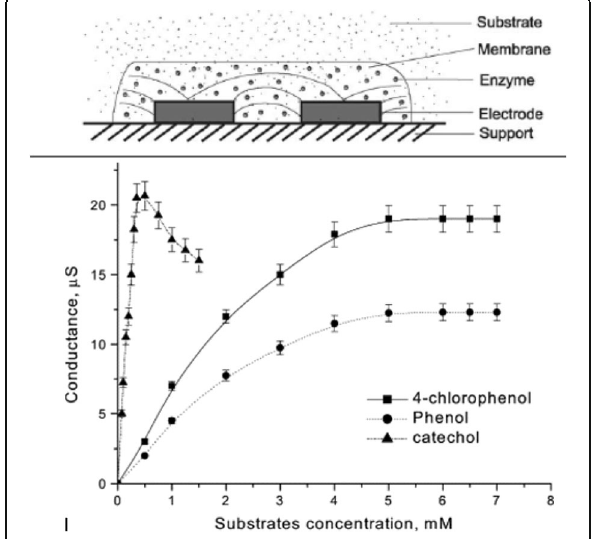
Fig. 14 a Nyquist plots of the MCH/aptamer/AuNPs/gold electrode correspond to different concentrations of acetamiprid. b The dependence of R et of on the concentration of acetamiprid; inset is the linear calibration curve of with permission from Reference Fan et al. 2013). © 2013 Elsevier